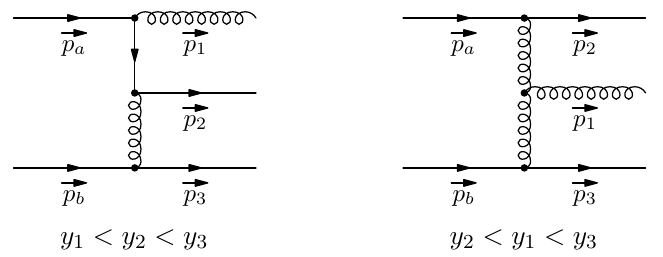
gqQ . The ordering in eq. (2.17) (left) !